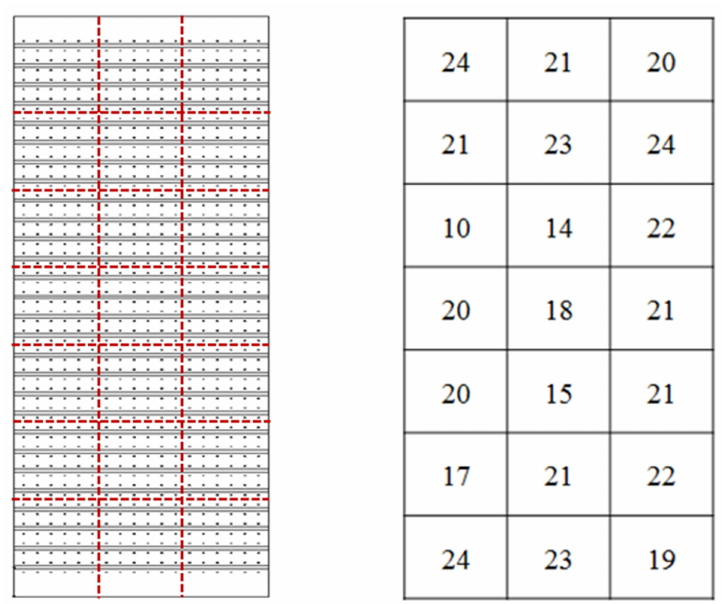
Figure 10. ( a ) The injection divisions of AIG (top view); ( b ) The corresponding non-uniformed NH 3 injection strategy (unit: m/s).